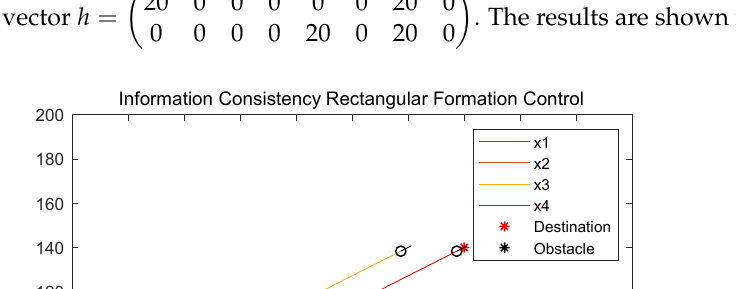
Figure 15. Formation motion control protocol.